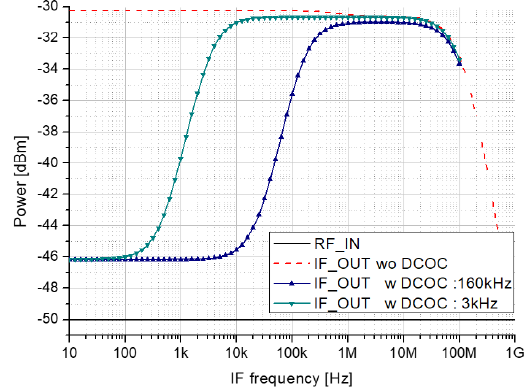
Figure 22. IF-stage gain simulation